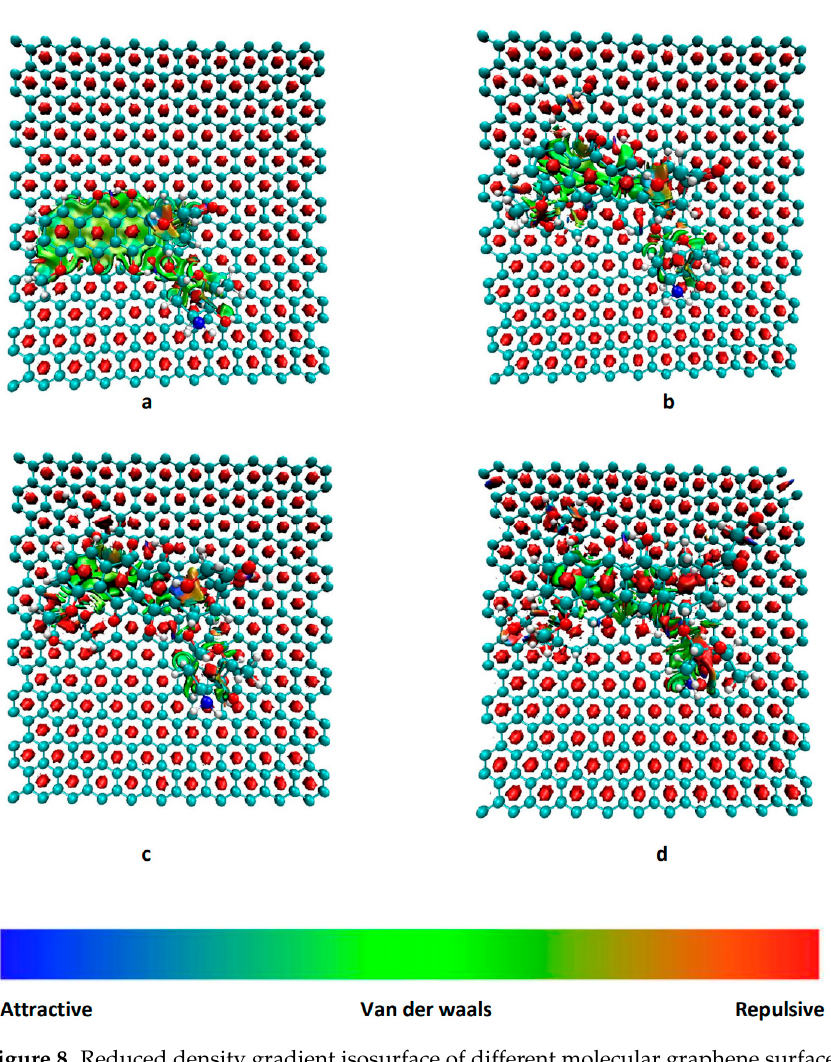
Nanomaterials 2022 , 12 , x FOR PEER REVIEW Figure 8. Reduced density gradient isosurface of different molecular graphene surfaces. ( a ) G-DOX; ( b ) GO-OH-DOX; ( c ) GO-O-DOX; ( d ) GO-OH-O-DOX.